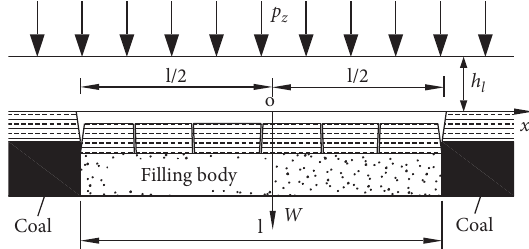
Figure 8: Mechanical model of the main roof under